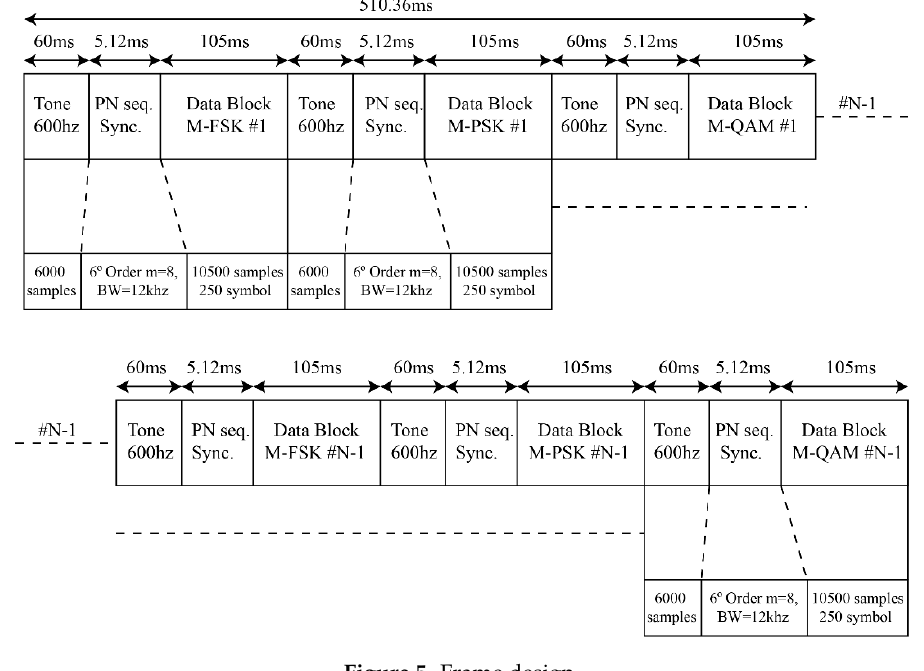
Figure 5. Frame Figure 5. Frame design.